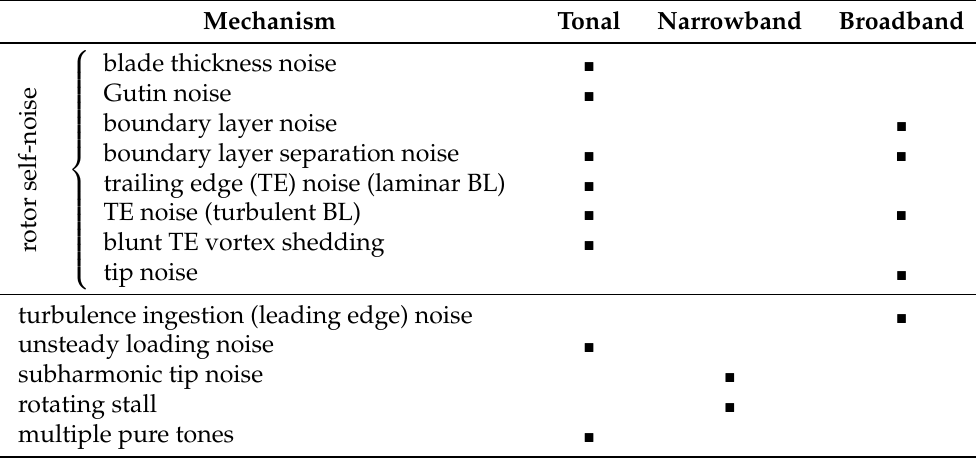
Table 1. Aeroacoustic sources and characteristics in axial fans associated with the rotor, adapted from [5,30–33]. The marker (cid:4) describes the occurrence of a mechanism.